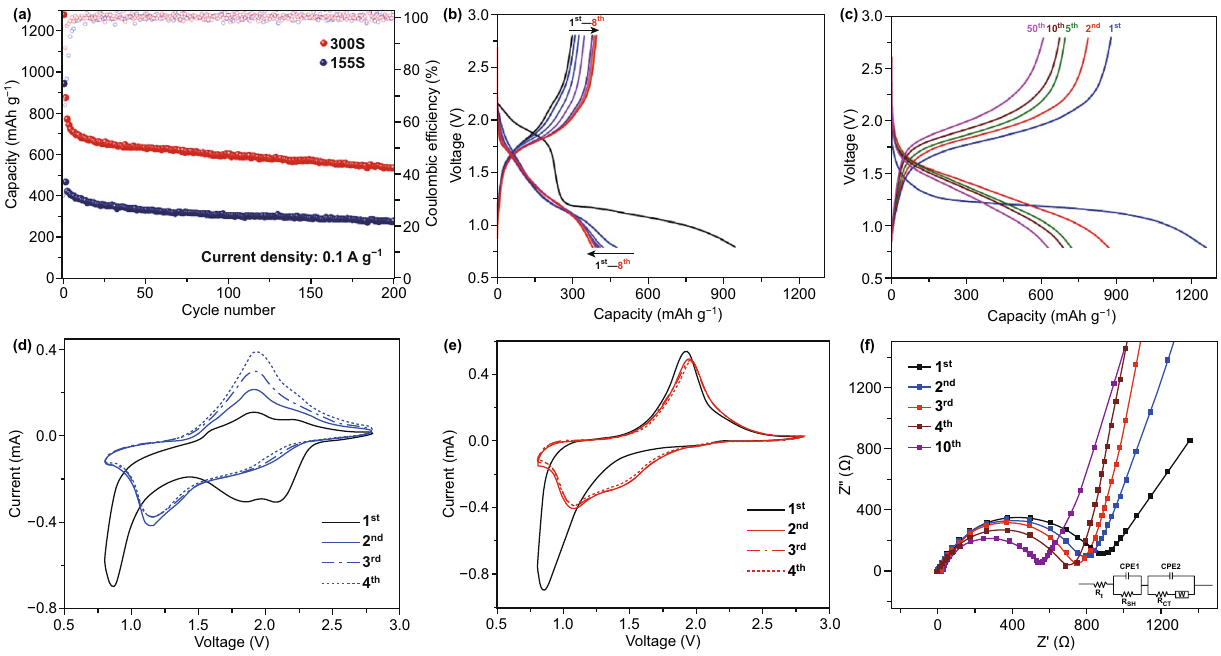
Fig. 3 a Electrochemical cycling performances of the 155S and 300S samples at 0.1 A g −1 in carbonate‑based electrolyte. b Discharge/charge curves of the 155S at 0.1 A g −1 . c Discharge/charge curves of the 300S at 0.1 A g −1 . d CV curves for the 155S at 0.1 mV s −1 . e CV curves for the 300S at 0.1 mV s −1 . f EIS spectra of the 155S electrode, with the inset equivalent circuit used to interpret the